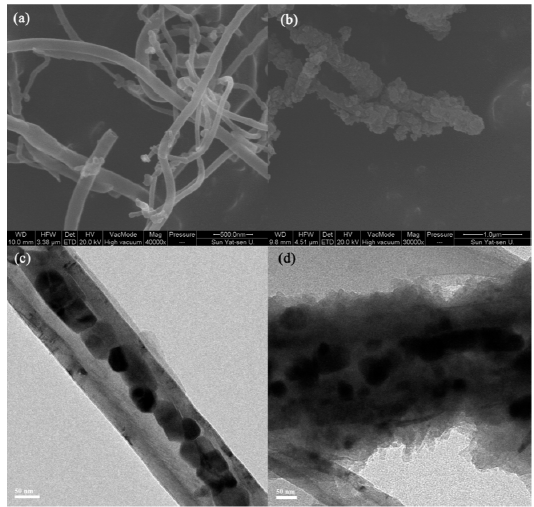
Figure 6. The SEM ( a , b ) and TEM ( c , d ) spectra of CNTs ( a ), magnetic CNT ( c ) and CoFe 2 O 4 @CNT@COF ( b , d ). Reprinted from [83] with permission of Elsevier.